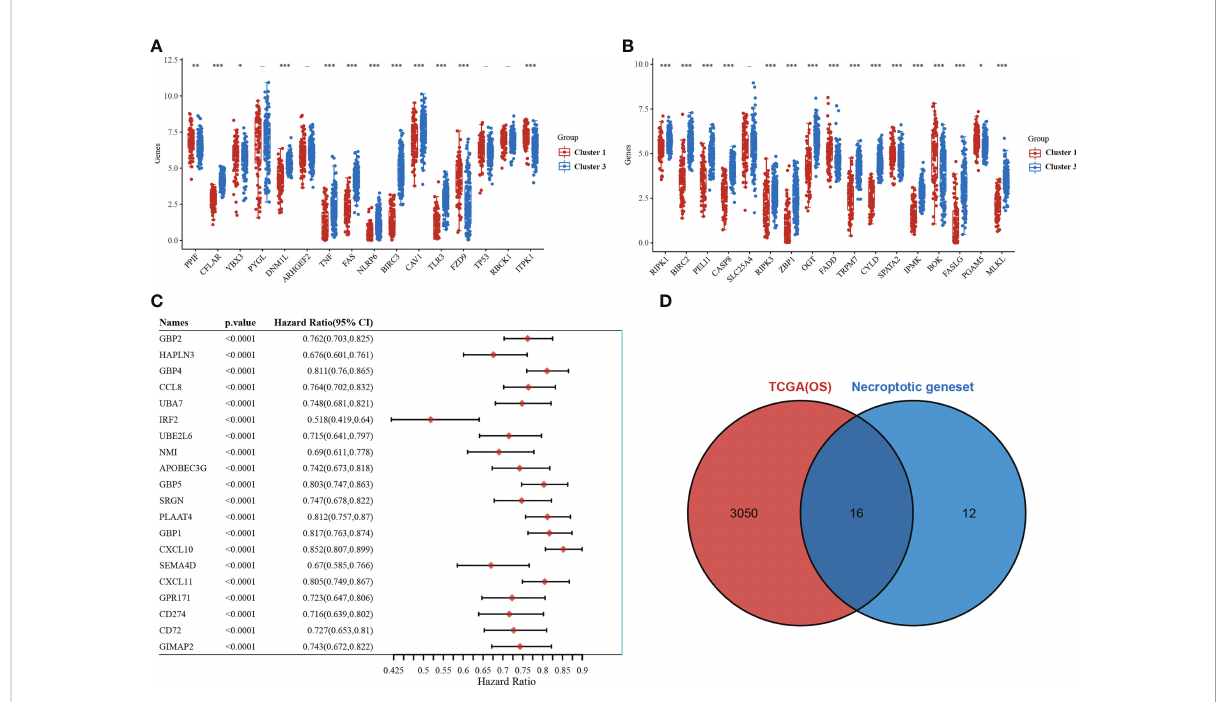
FIGURE 2 Necroptosis-related genes associated with prognosis. (A, B) Differential expression of necroptosis-related genes between the C1 and C3 subgroups. (C) Results of the whole genome survival analysis of cutaneous melanoma showing the top 20 genes. (D) Venn diagram. *p<0.05, **p<0.01,